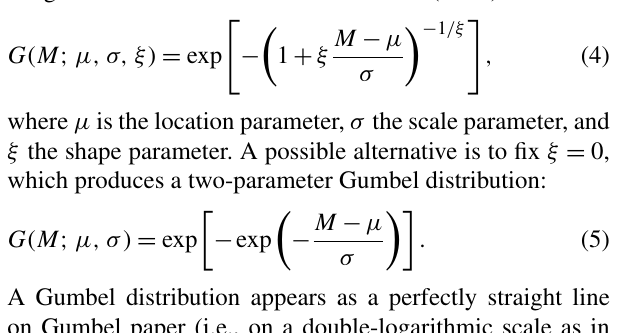
Figure 4. Return level plot of the tower base overturning moment by a weighted sum of the bins shown in Fig. 3 (i.e., fitting before ag- gregation), using an equivalent 96-year sample size. The weighted distribution is given by a black dashed line and is overlaid on Fig. 2 for